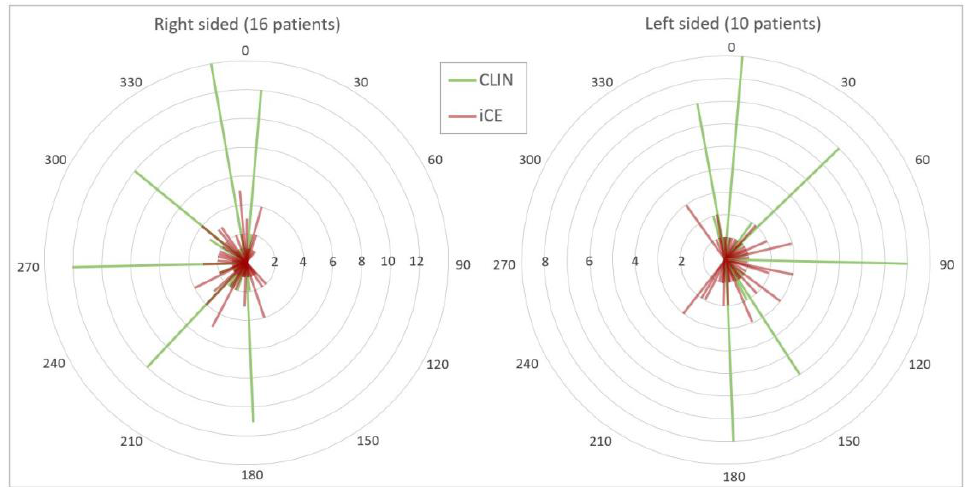
Figure 3. Selected beam angles in the CLIN plans (green) and optimized beam angles in the iCE plans (red) for patients with right-sided and left-sided tumors. Angles are rounded to the nearest 5 degrees. The number of patients is shown on the radial axis, and the angular axis shows beam angle in degrees.